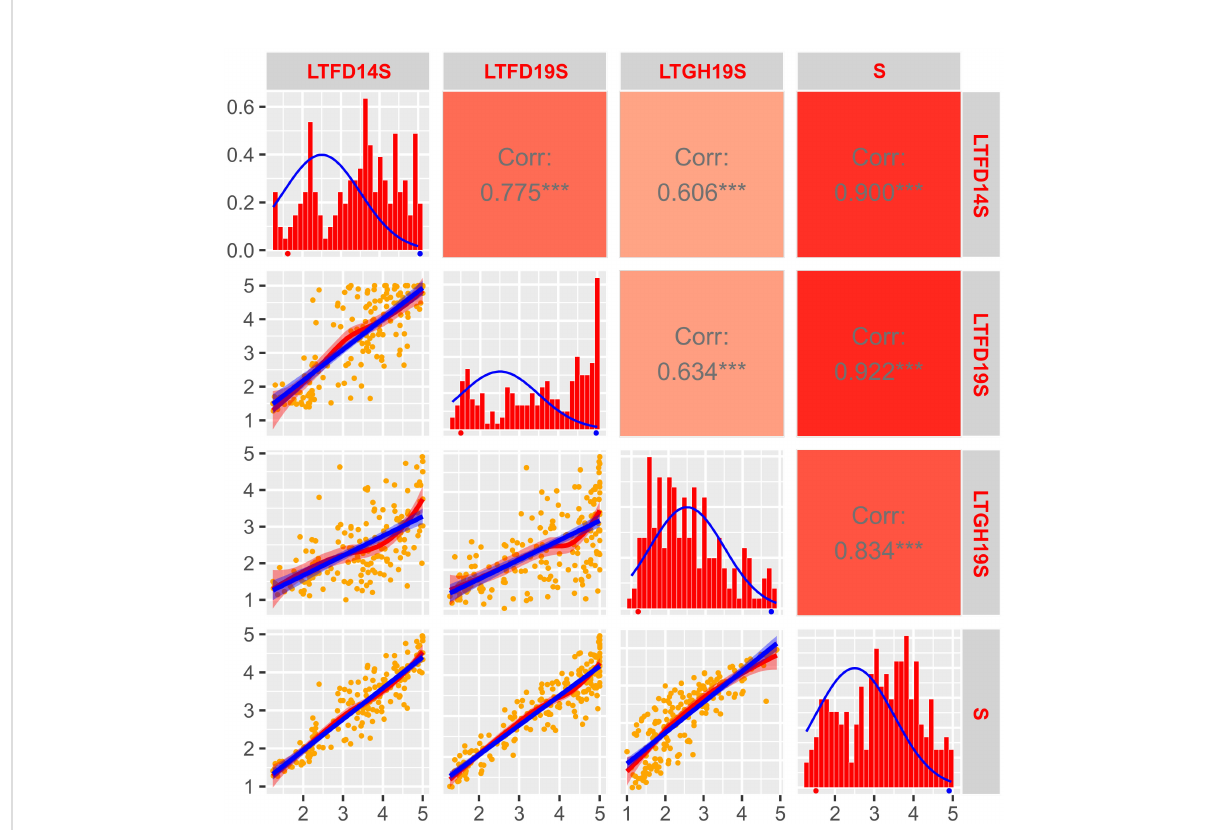
FIGURE 2 Frequency distribution and correlation scatterplots for solid stem rating of doubled haploid population ‘ Sadash/P2711 ’ . Frequency distribution histograms with distribution curve (blue line) for solid stem score of DHs grown at Lethbridge, Alberta in the fi eld in 2014 (LTFD14S) and 2019 (LTFD19S) and greenhouse in 2019 (LTGH19S), as well as pooled data (average of all three environments; S) are shown on main diagonal. The means of the parental genotypes, Sadash (hollow-stemmed) and P2711 (solid-stemmed), are indicated by red and blue dots, respectively, beneath the frequency distribution plots. Scatterplots with regression lines, linear (blue) and exponential (red), for each environment are shown on the left side of the main diagonal. Orange dots on scatterplots represent the solid stem score of DHs. Correlation coef fi cients ( r ) between each pair of environments, and each environment and the pooled data, are displayed on the right side of the main diagonal. Color intensity (light red to dark red) on r boxes indicates the depth of association between environments under evaluation. ***p ≤